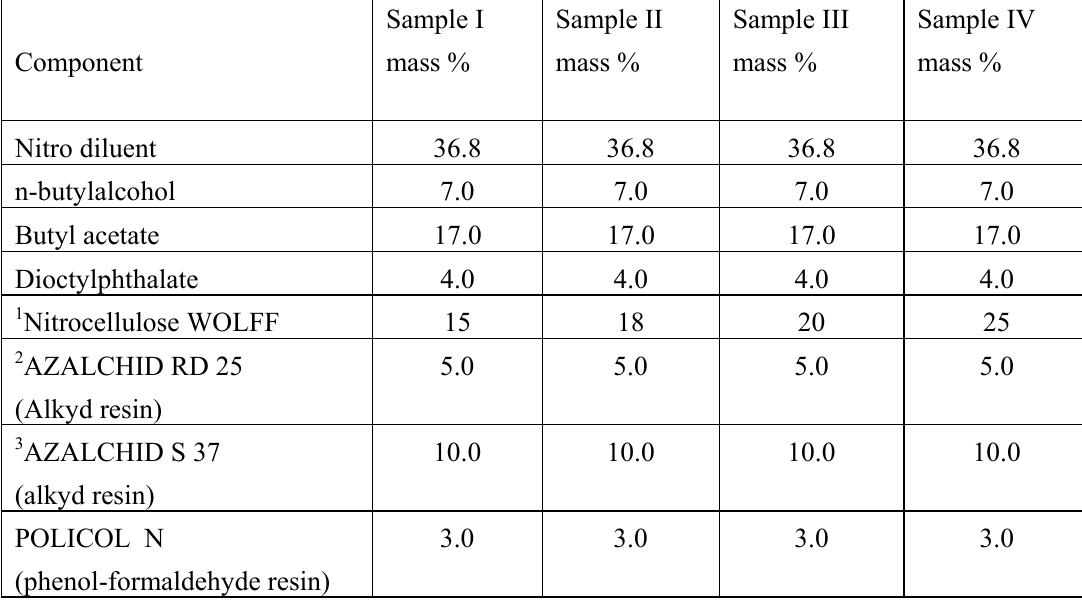
Table 2. Prescription content of colourless